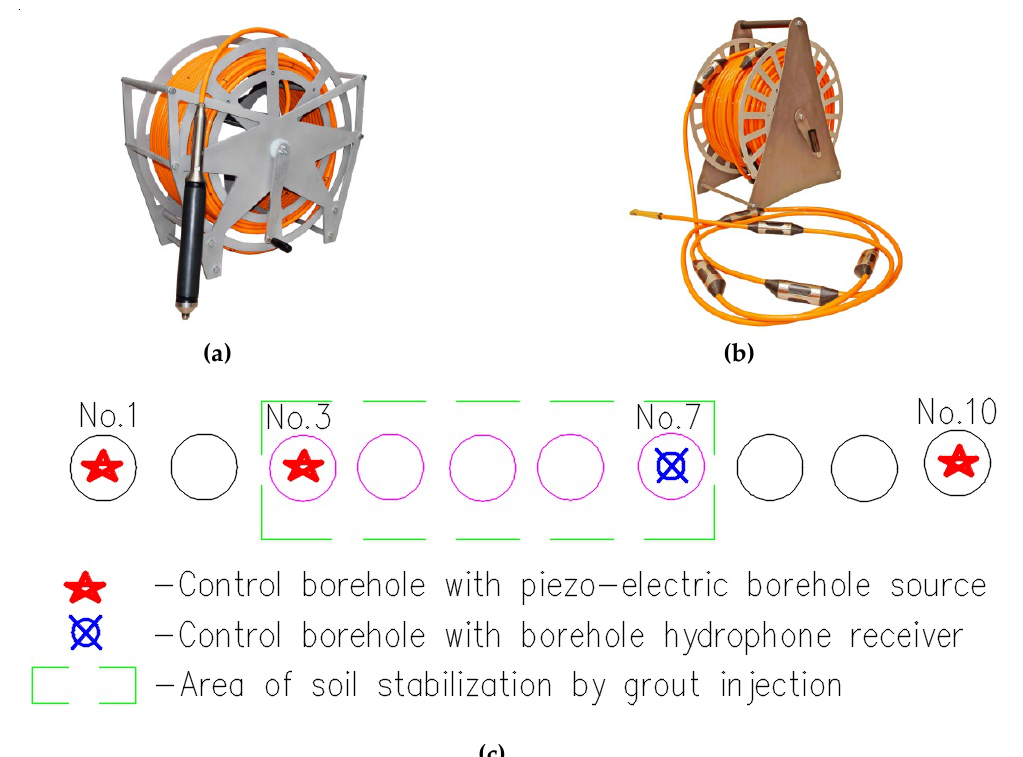
Figure 2. Description of borehole measurements, acquisition configuration, and logging instrumentation. ( a ) piezo-electric borehole source; ( b ) borehole hydrophone receiver; ( c ) the scheme of observations.